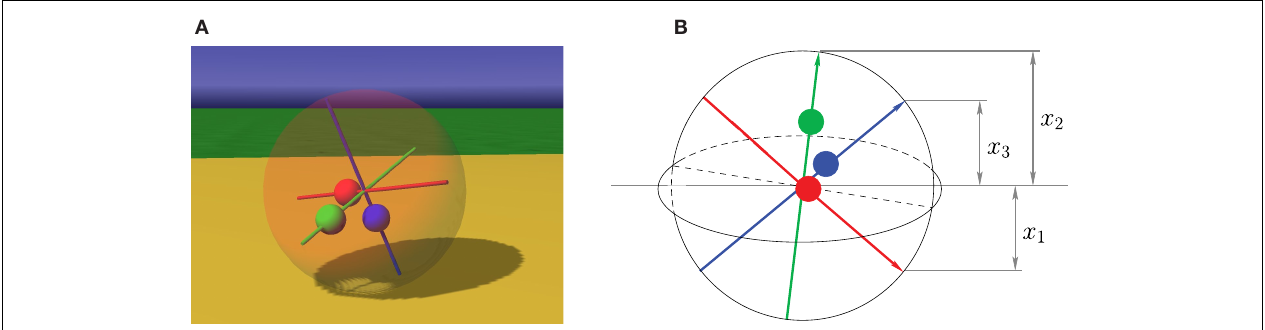
FIGURE 1 | Spherical with axis-orientation sensors . (A) Screenshot from a simulation. The red, green , and blue masses are moved by actuators (linear motors) along the axes. (B) Schematic view of the robot with axis-orientation sensors ( x i ), with x 1 < 0. The masses can interpenetrate each other but are otherwise “normal” physical objects. Proprioceptive sensors report the position of the masses on their respective axis.